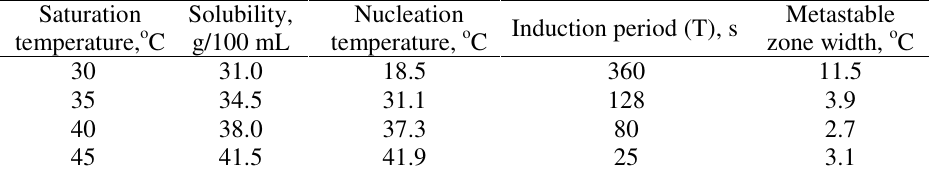
Table 1 . Solubility, induction period and metastable zone width of